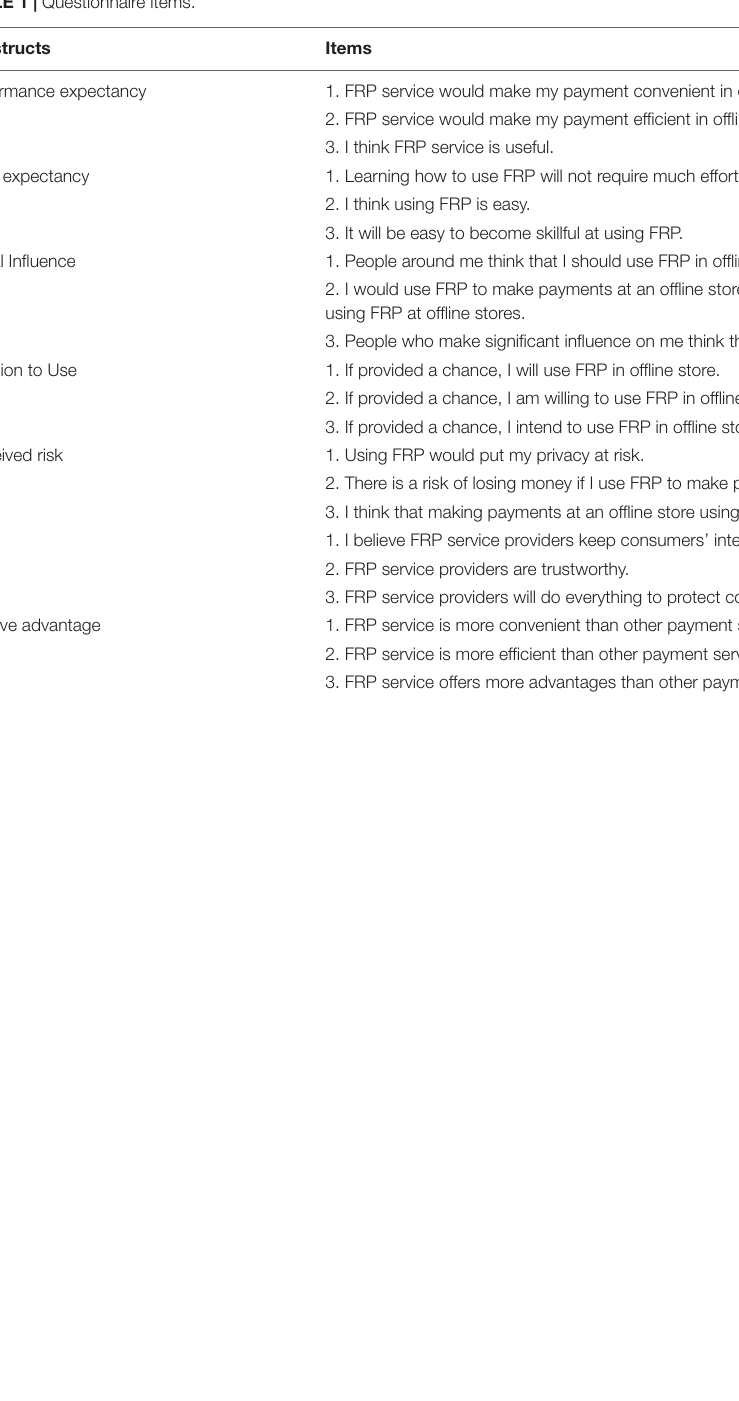
TABLE 1 | Questionnaire